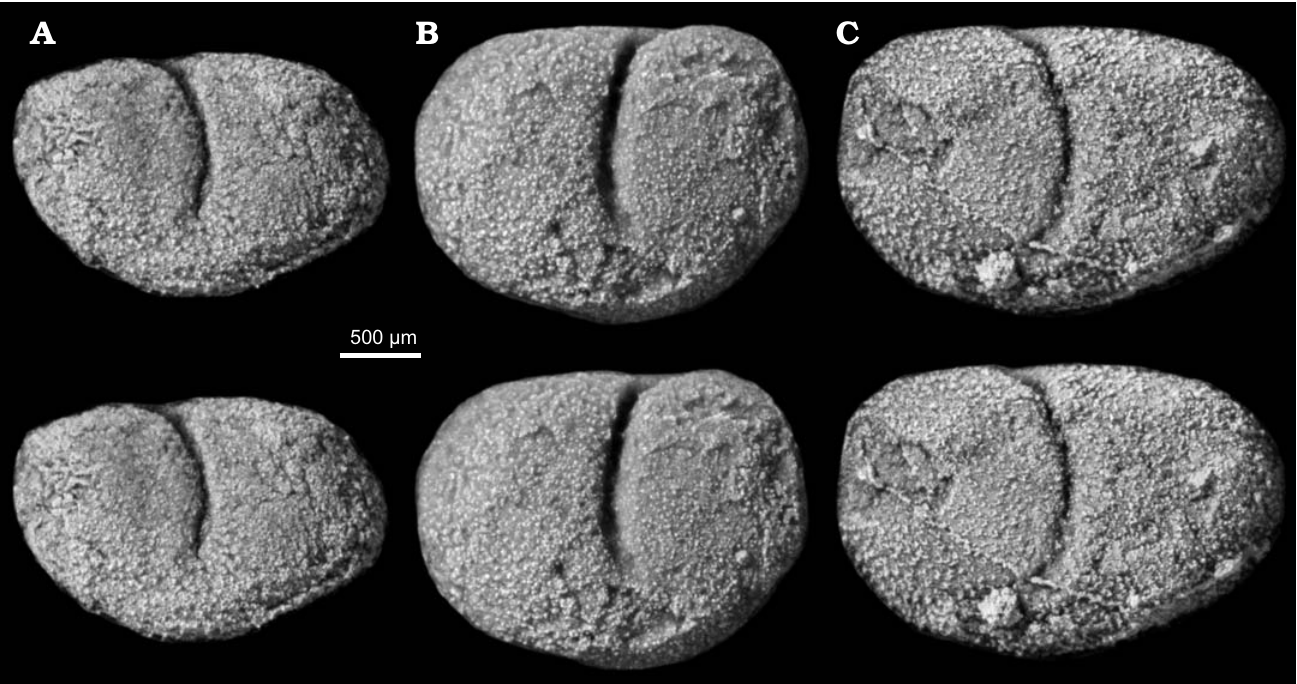
Fig. 5. Myodocope ostracod Nudator elegantulus sp. nov., Holy Cross Mountains, Poland; Ludlow Series, Silurian. A . ZPAL O.63/13, left valve. B . ZPAL O.63/14, right valve. C . Holotype ZPAL O.63/15, left valve. Light stereo-pair photographs in lateral view (of silicone casts of external